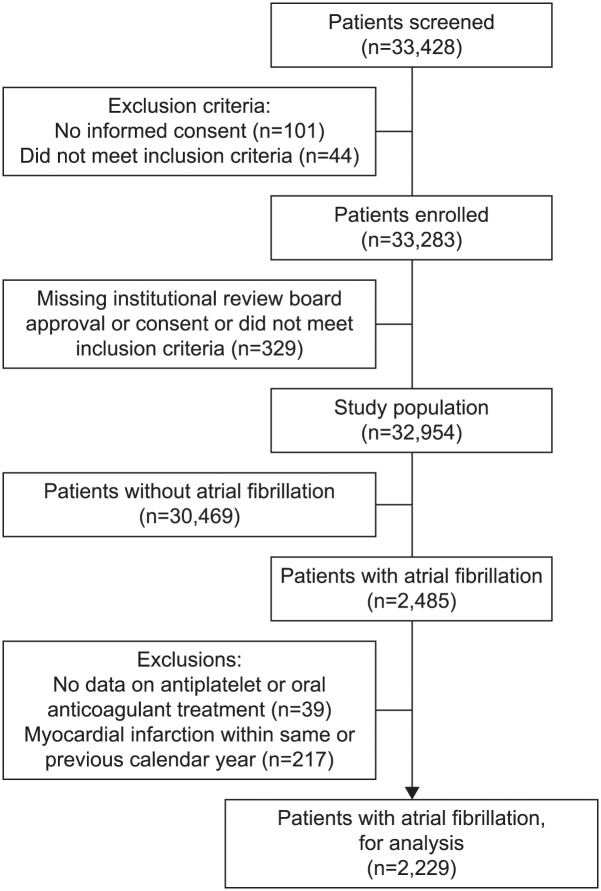
Patient flow chart.